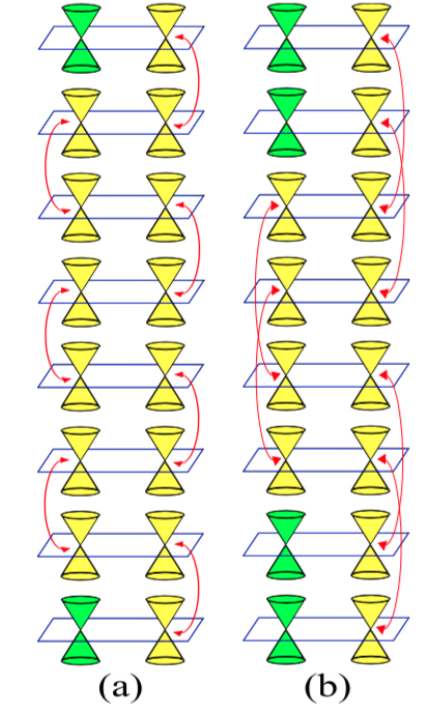
Figure 9: a) Schematic representation of the staggered interlayer mixing pattern of Dirac nodes. Interlayer couplings are represented by red arrows. The degenerate Dirac points at the ends of the red arrows mix and split, opening up a gap. A surface Dirac node colored green is left behind. b) A pair of surface Dirac nodes can arise as nodes are mixed in fashion separated by two layers. Mixing in this fashion requires a chiral